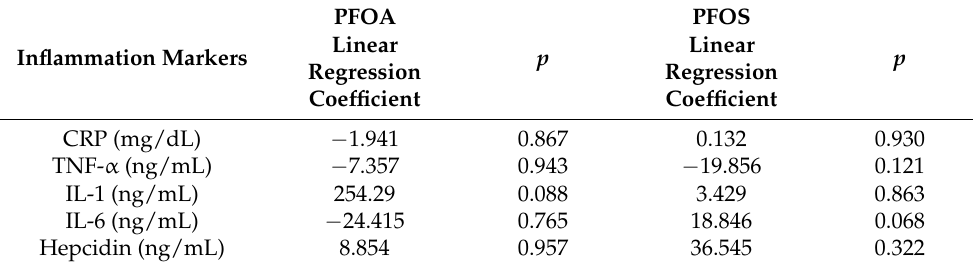
Table 4. Linear regression of inflammation markers associated with